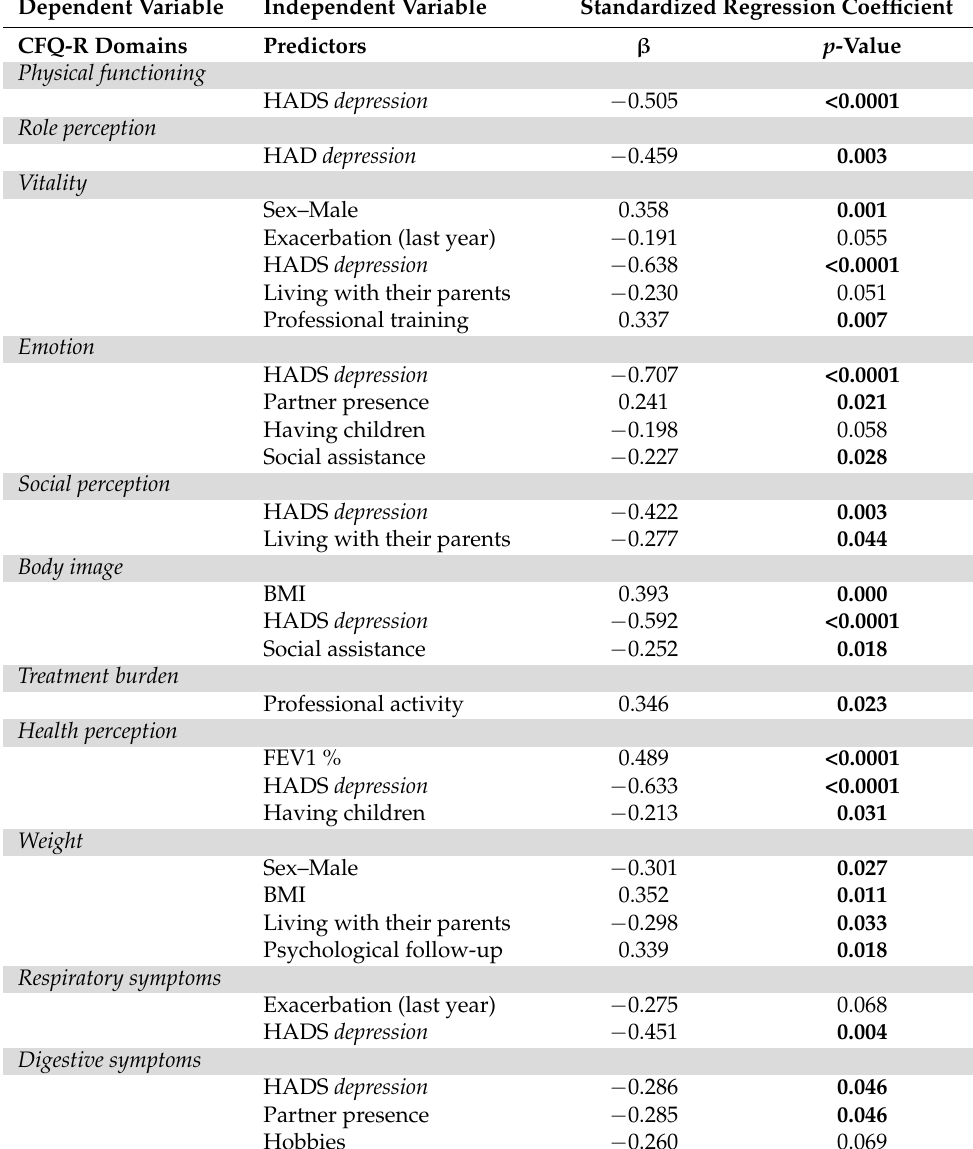
Standardized Regression